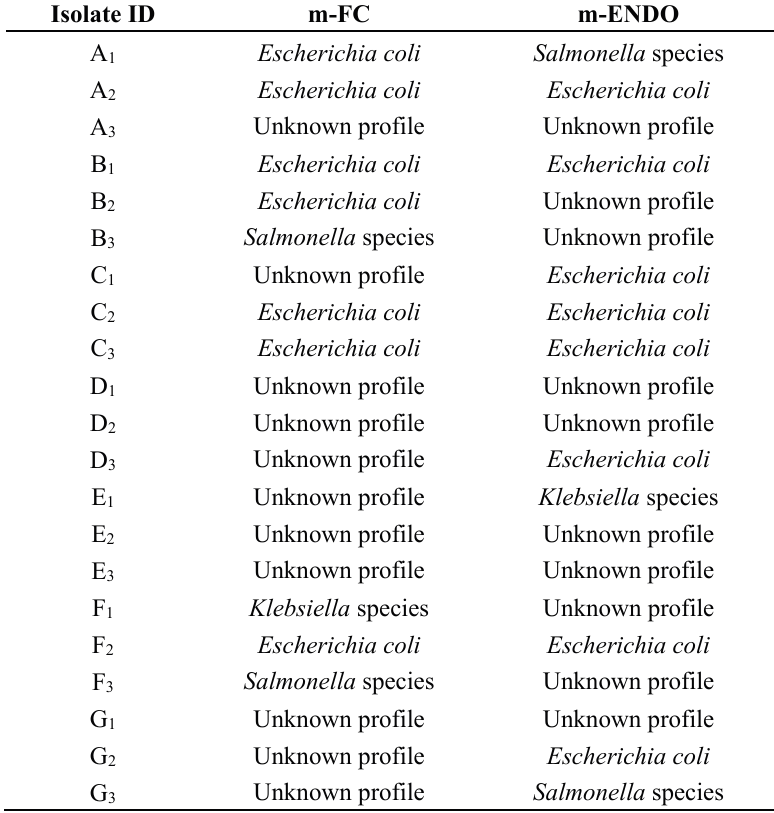
Table 5. Identities of the isolates from m-FC and m-ENDO based on the biochemical profiles. Isolate ID